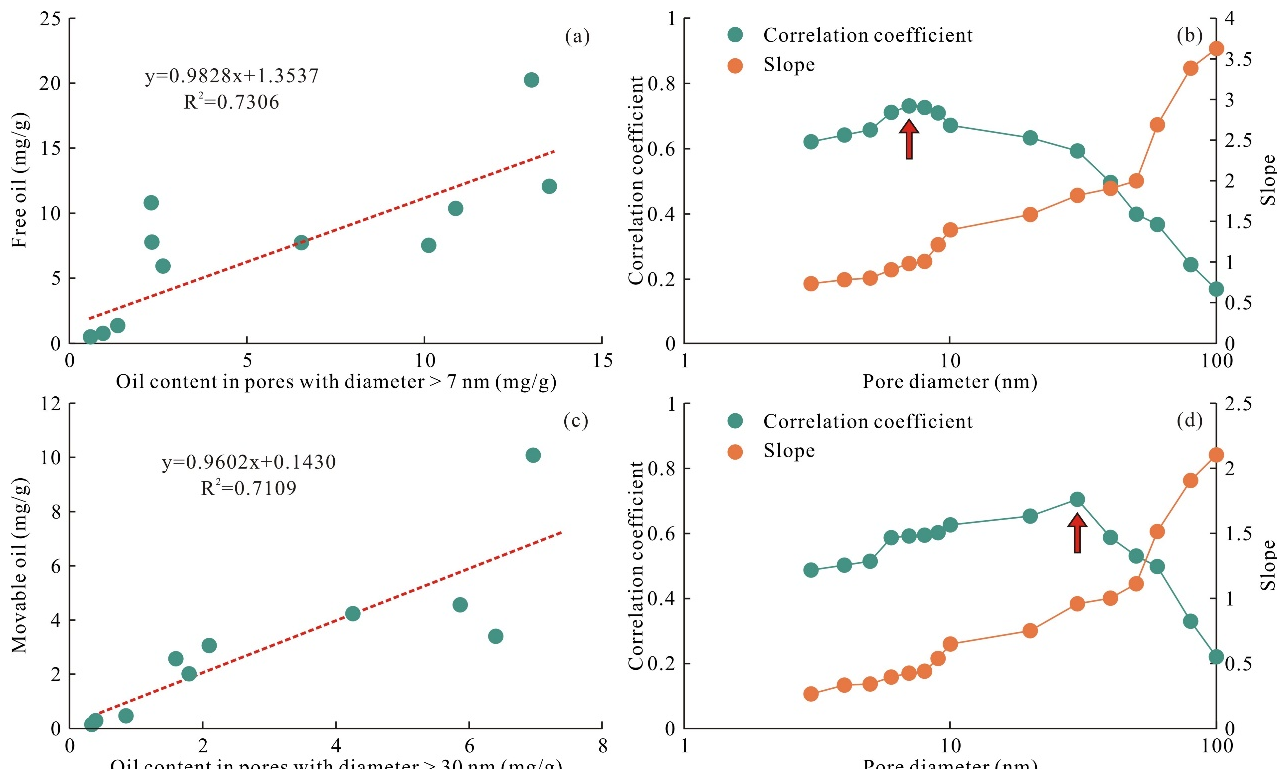
Figure 11. Lower limits of the pore diameter of the occurring free oil and movable oil in the Ek 2 shales in the Cangdong Sag. ( a ) Correlation between free oil and oil content in pores with diameter >7 nm. ( b ) Correlation between pore diameter and correlation coefficient and slope of free oil. ( c ) Correlation between free oil and oil content in pores with diameter >30 nm. ( d ) Correlation between pore diameter and correlation coefficient and slope of movable oil.